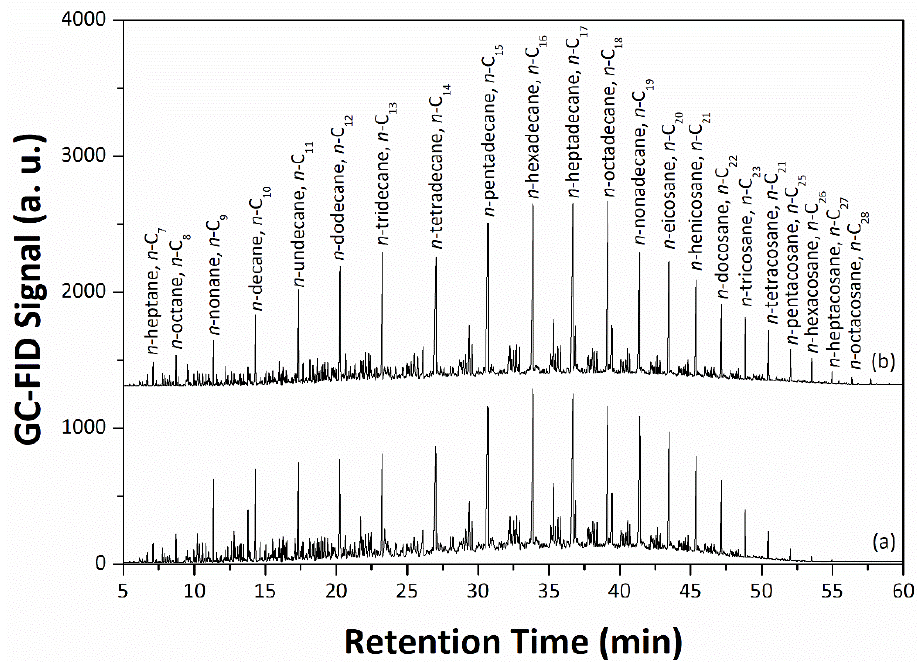
Figure 8. Gas chromatography–mass spectrometry (GC-FID) profiles of (a) commercially available petroleum diesel and (b) hydrotreated oil, which was produced by hydrotreating Jatropha bio-oil (10 wt %) co-fed with LGO over the mesoporous NiMo/γ-Al 2 O 3 sulfide catalyst on an up-flow fixed-bed reaction system (350 C, 7 MPa of H 2 and 1.5 h −1 of WHSV).